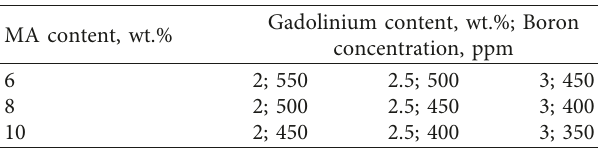
Figure 3: Infinite multiplication factor (k-inf) of the VVER-1000 LEU fuel assembly versus burnup obtained with SRAC and MCNP6 calculations. Table 3: MA content, gadolinium content, and boron concen- tration used in this